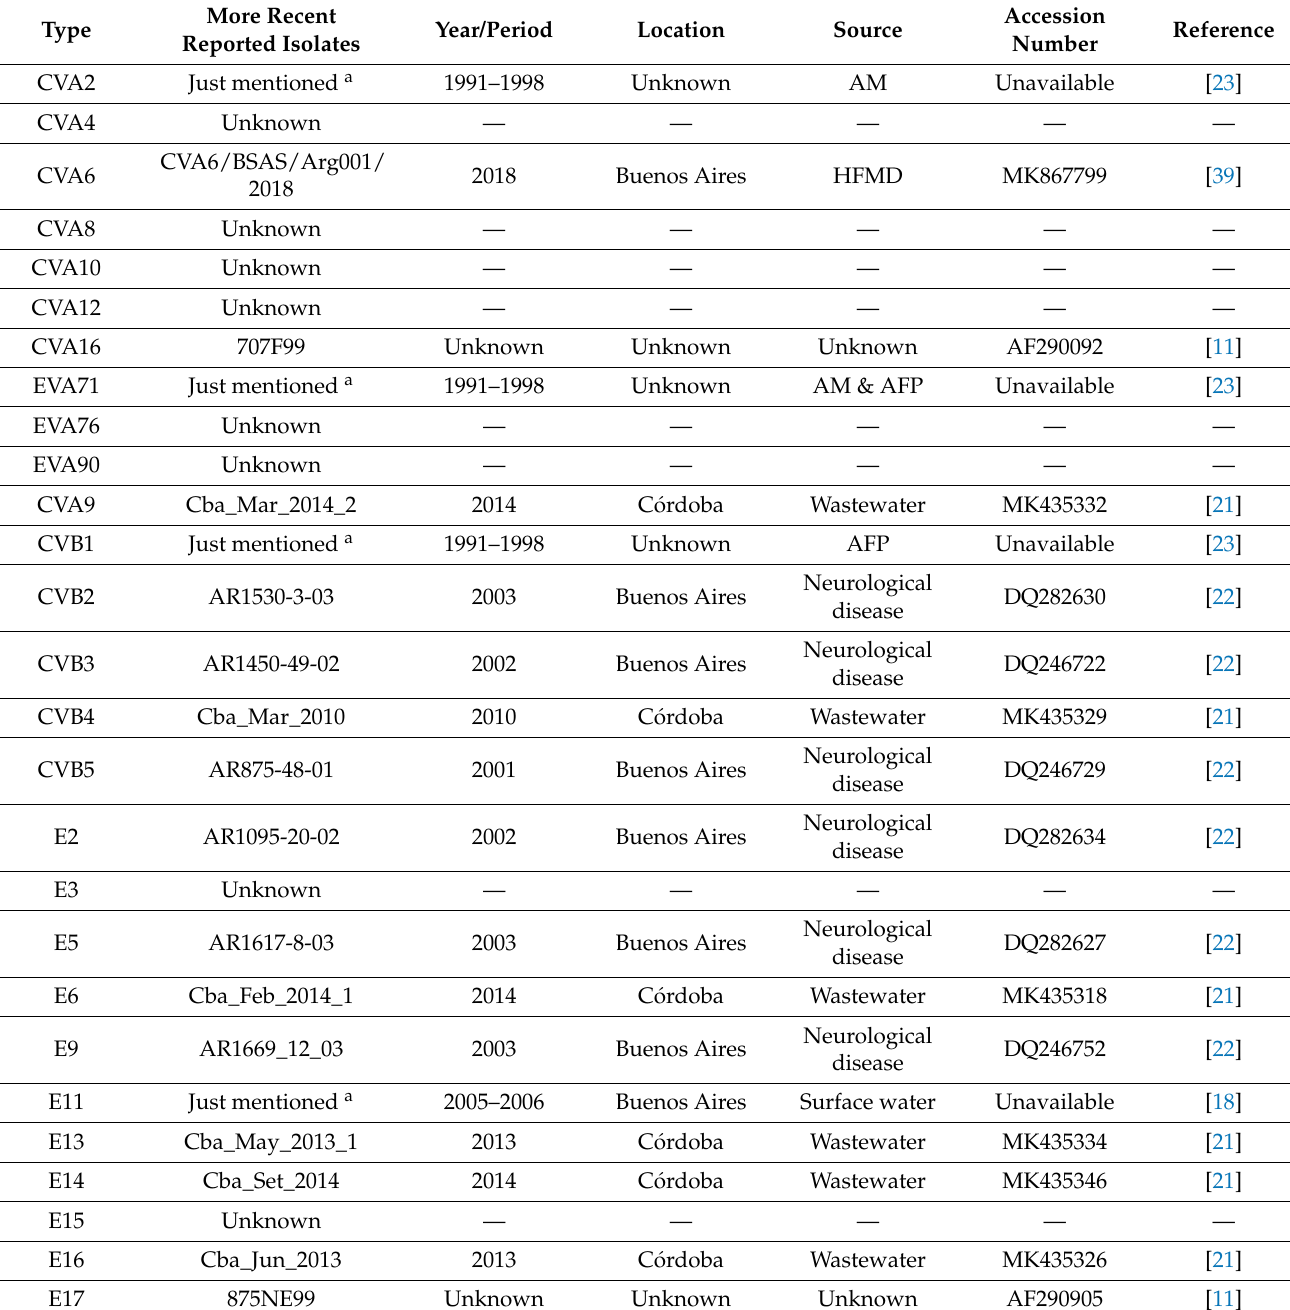
Table 2. Backgrounds of circulation in Argentina for Human Enteroviruses types detected in this